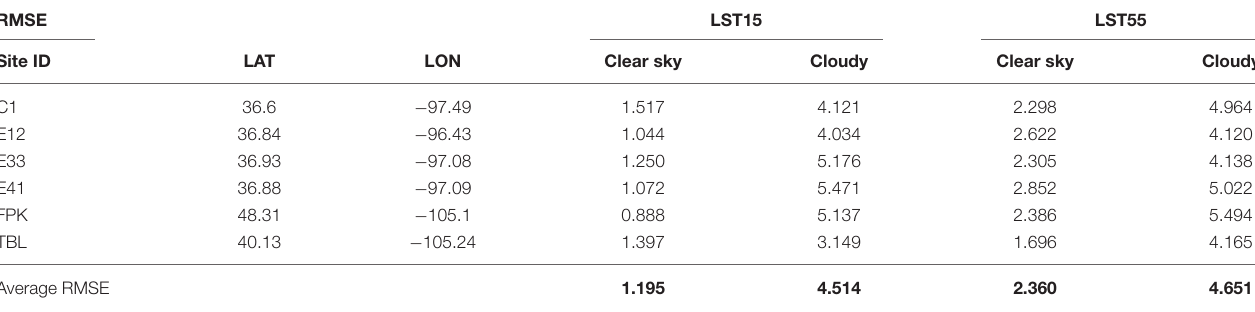
TABLE 2 | RMSE of MW-TIR coupled LST validated against in-situ observations (Jan. 26–Dec. 31 2018); statistics of clear sky pixels and cloudy pixels are separated. RMSE